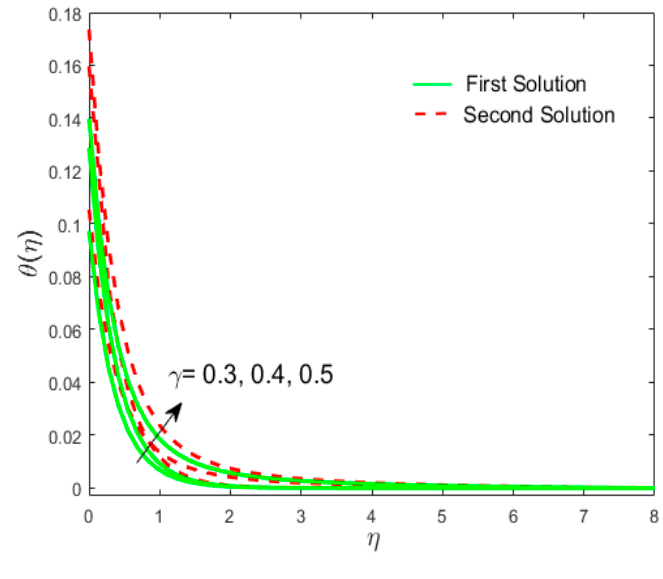
Figure 13. Influence of γ on θ ( η )